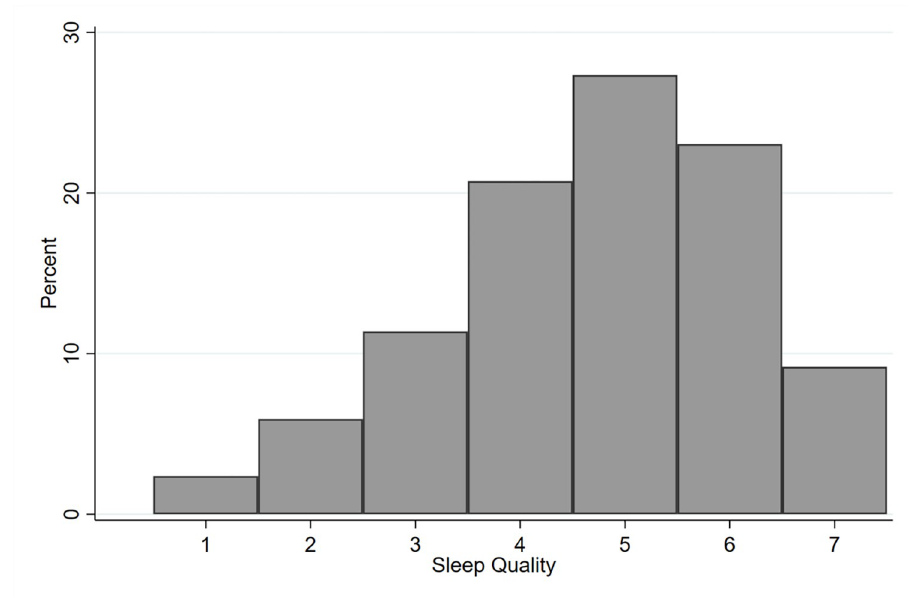
Fig 1. Distribution of sleep quality–estimation sample. Note : These numbers refer to respondents from our estimation sample (28,572 observations) coming from the four 2020 waves and the first two 2021 waves of the COME-HERE survey.